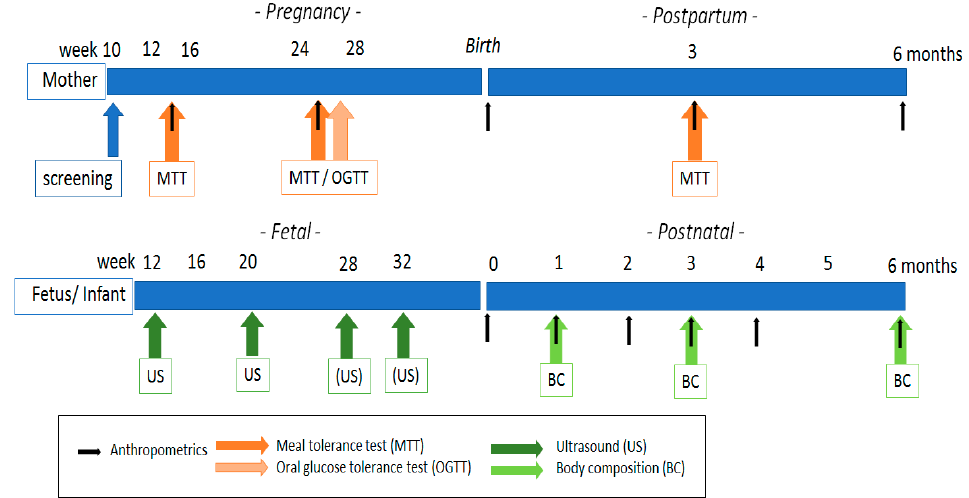
Figure 1. Schematic representation of the prospective cohort indicating readouts and proposed timing of measurement between early pregnancy up to 6 months postpartum in both mother (upper panel) and offspring (lower panel).